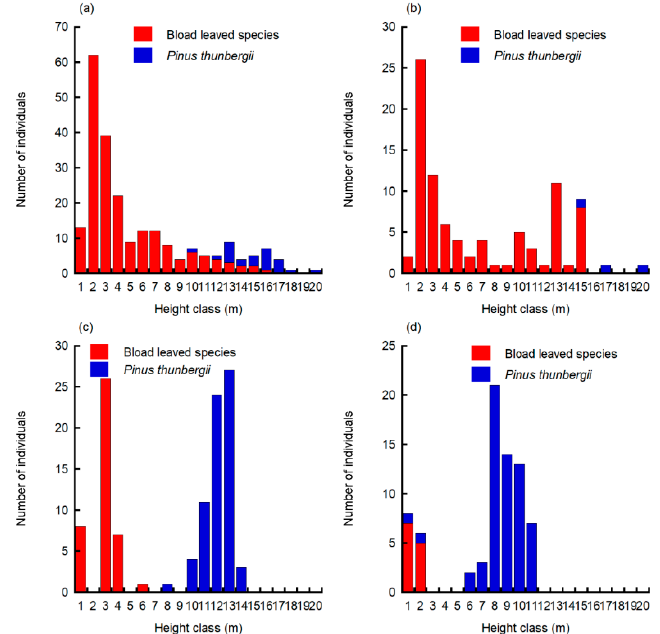
Figure 2. Number of individuals of tree species in ( a ) quadrat A (mixed stand), ( b ) quadrat B (broadleaf stand), ( c ) quadrat C ( Pinus dominated stand), and ( d ) quadrat D (pure Pinus stand) in the Sanri-Matsubara Forest, south-western Japan, Dominant broadleaf species include Ligustrum japonicum , Cinnamomum japonicum , Cinnamomum camphora and Celtis sinensis var. japonica .